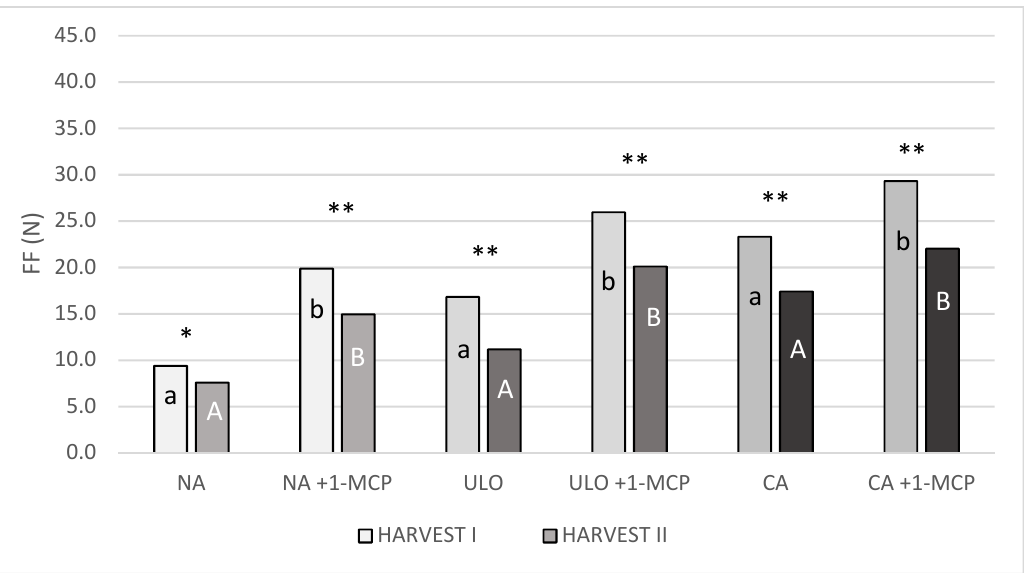
Figure 1. ‘Geneva’ fruit firmness (FF) depending on harvest time and 1-MCP treatment under three storage technologies. Statistically significant difference between first and second harvest fruit (Newman–Keuls range test): *—for 5%. **—for 1%. Different letters were assigned to statistically significant differences when comparing the effect of 1-MCP, separately for storage conditions.